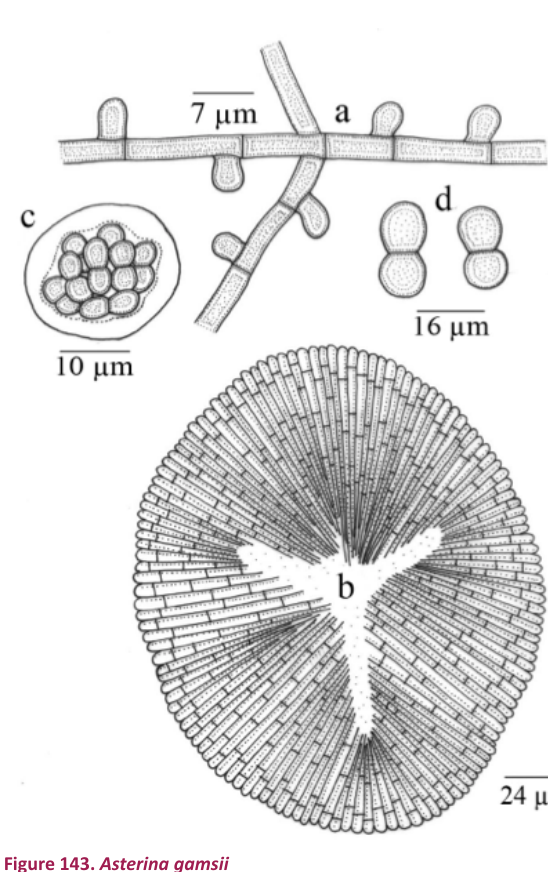
Figure 142. Asterina erythropalicola a - Appressorium; b - Thyriothecium; c - Ascus; d - Ascospores